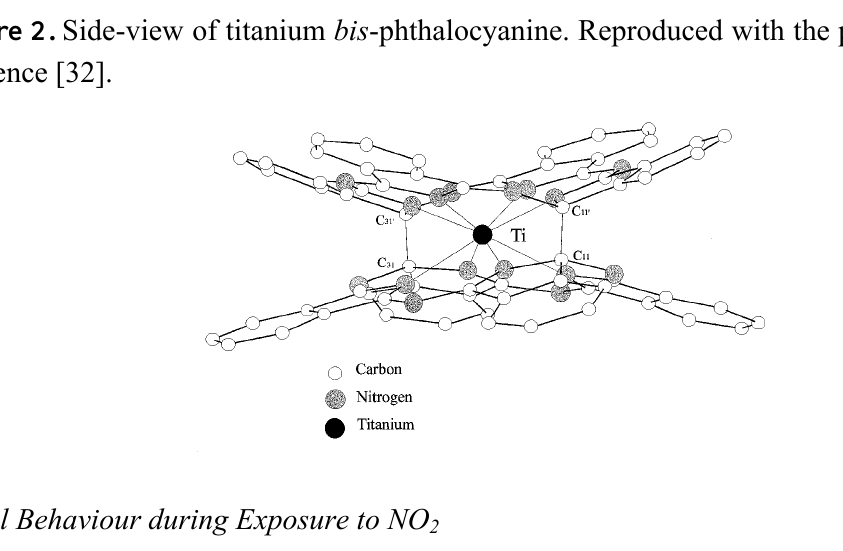
gas in N at RT: 2 2